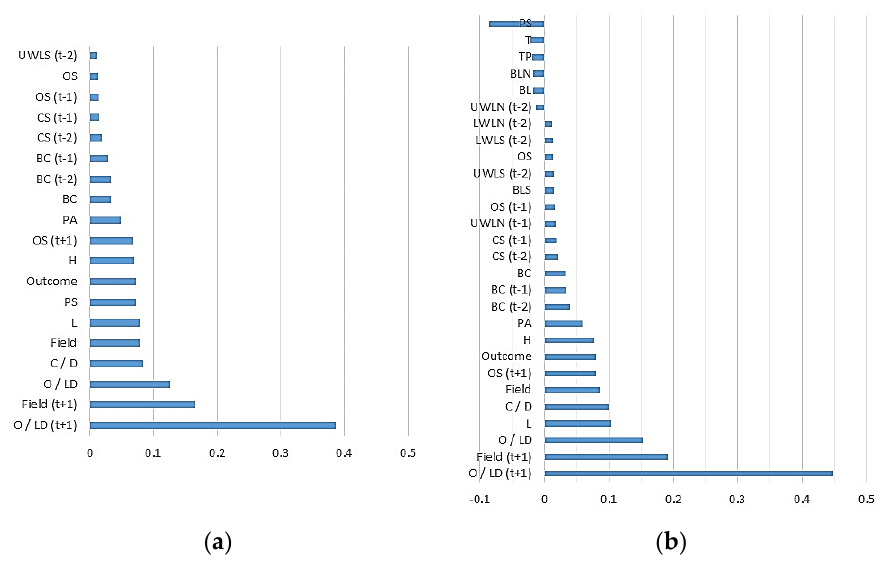
Figure 5. Correlation coefficients of selected features. ( a ) Classification-based models, ( b ) regression-based models.